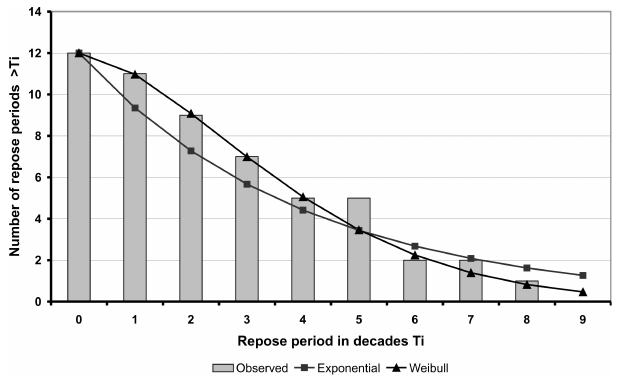
Fig. 4. Distribution of observed repose intervals with duration greater than T decades (bars) for the Canary Islands since 1402. The survival Weibull distribution shows a much better fitting than the exponential